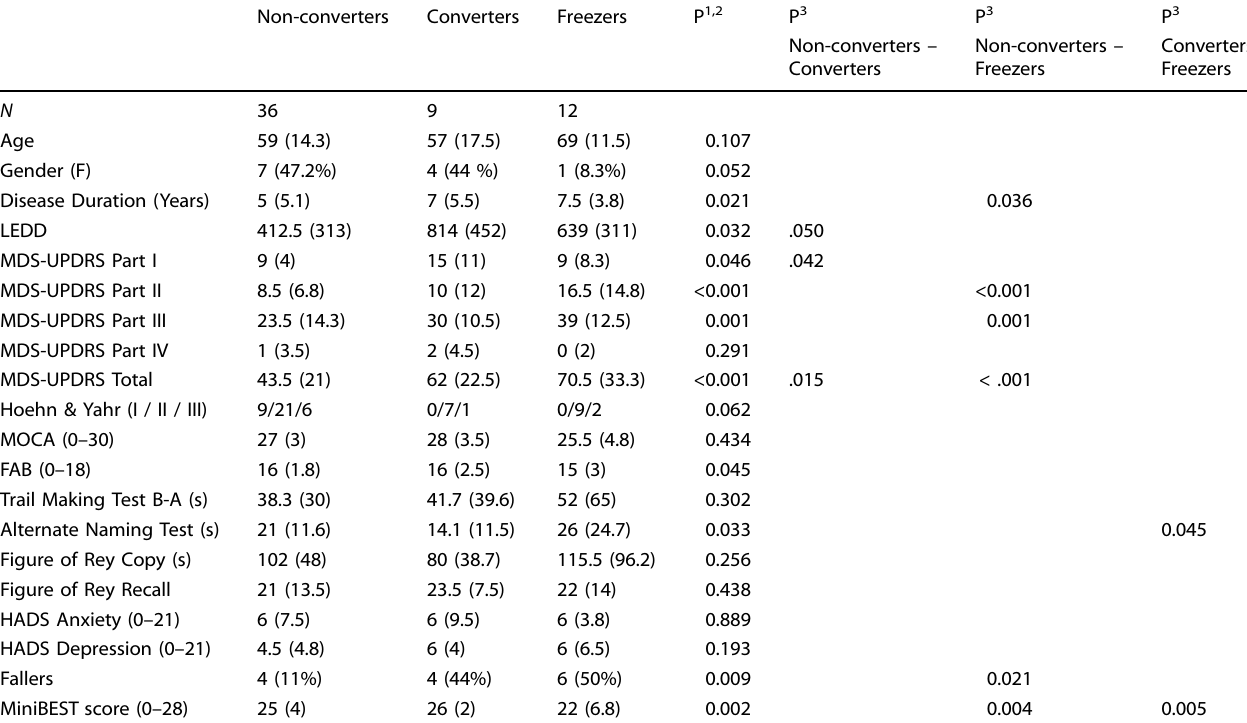
Table 1. Demographic differences between sub-groups at study